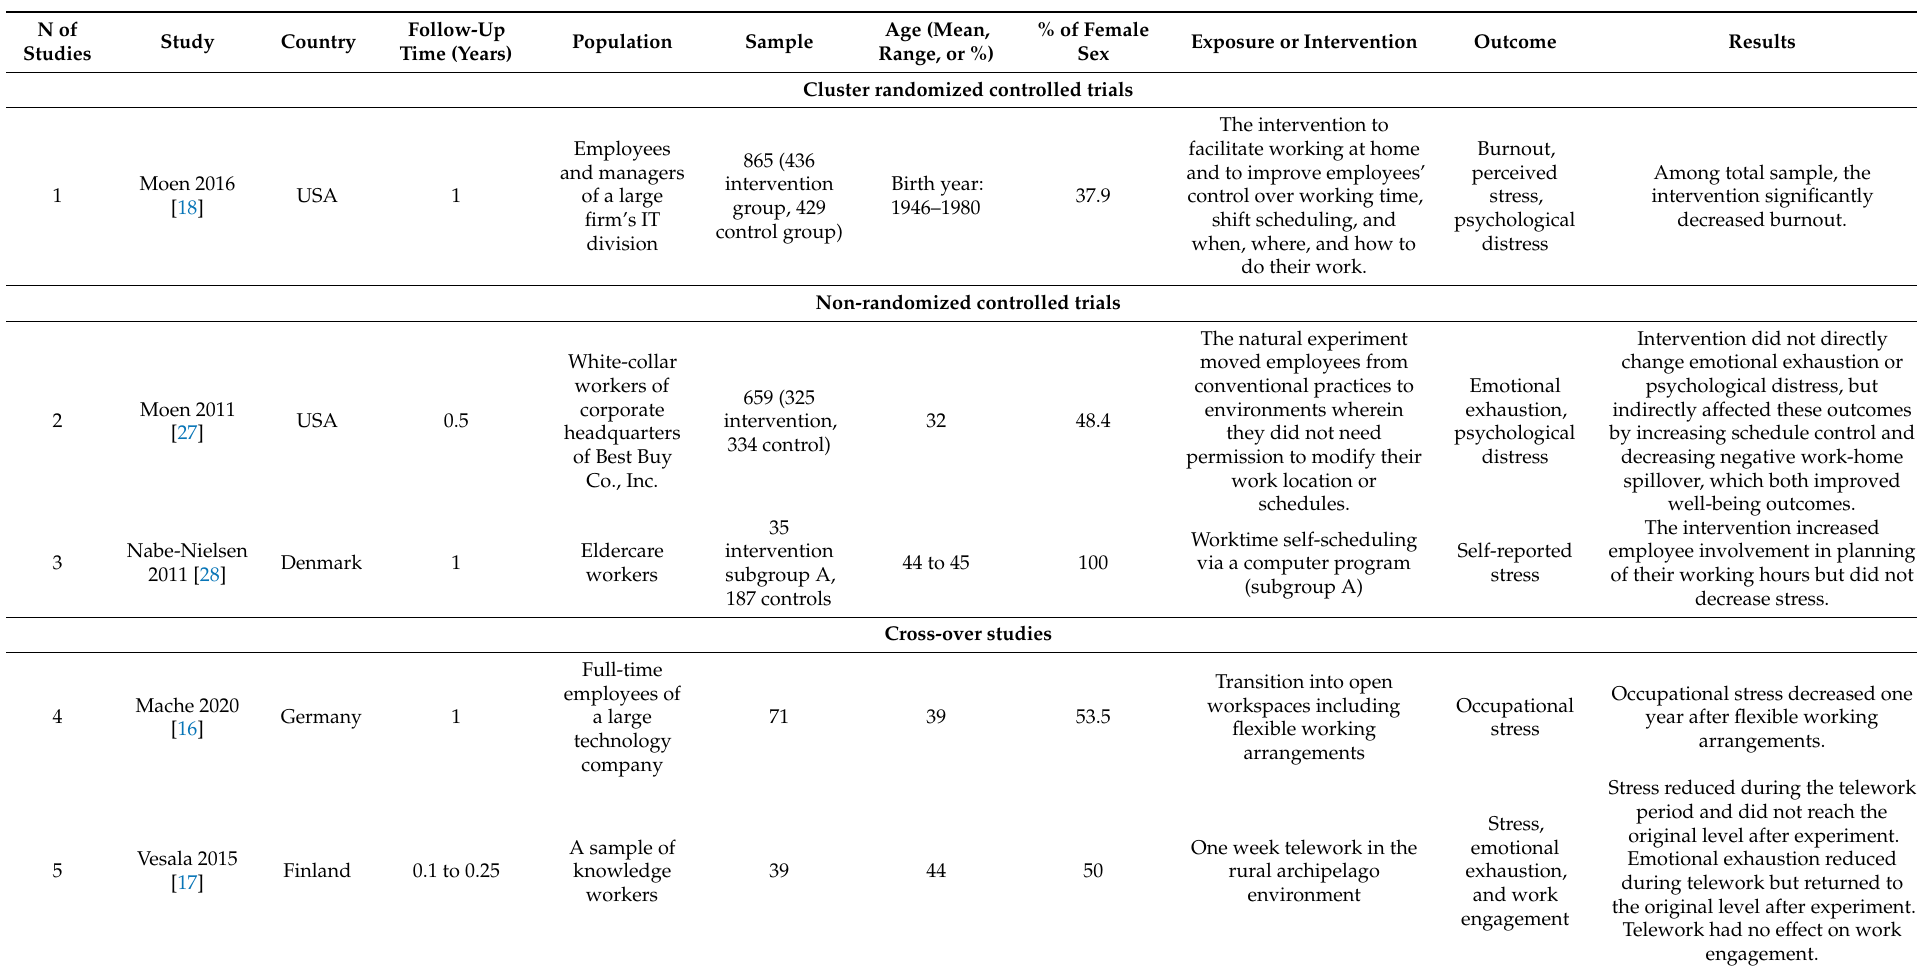
Table 1. Brief description of the characteristics of studies included in the